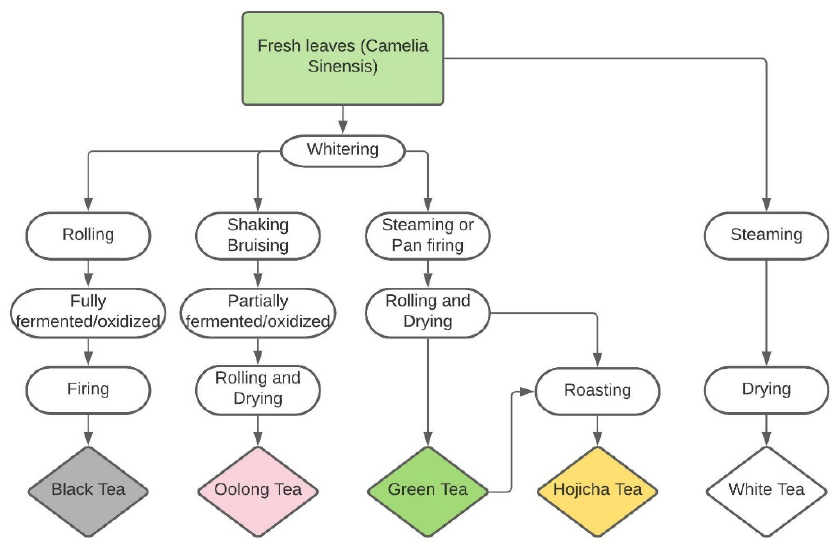
Figure 1. Different tea production processes.